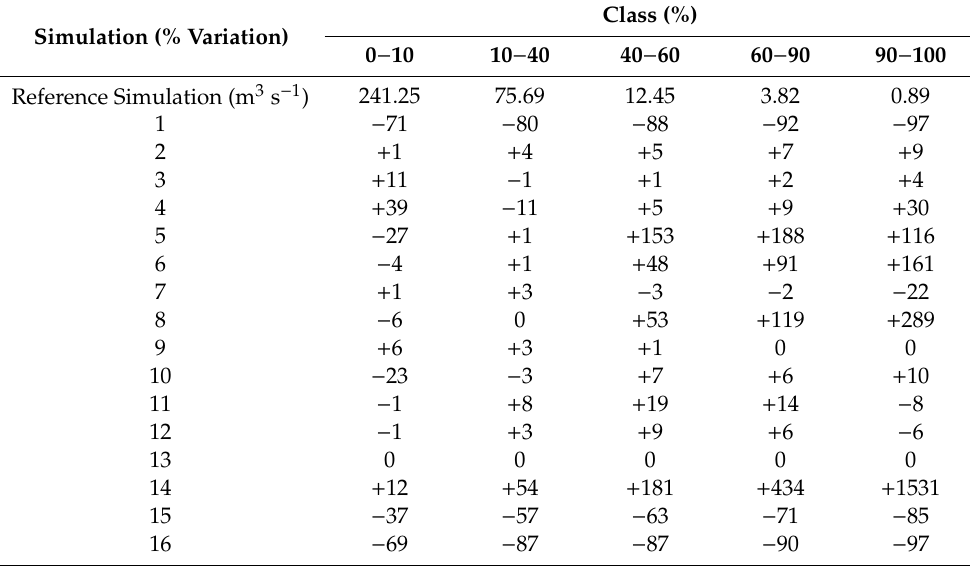
Table 4. Mean river flow values at the station Ulla-Teo for each exceedance probability class of the reference simulation flow-duration curve and respective variation in each class for each simulation scenario compared with the reference simulation.